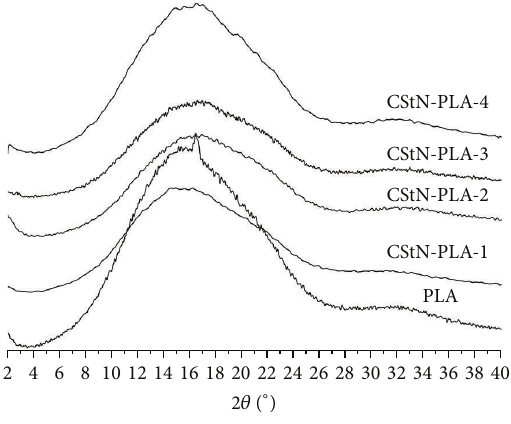
Figure 2: X-ray diffraction patterns of CStN/PLA nanocomposites and PLA